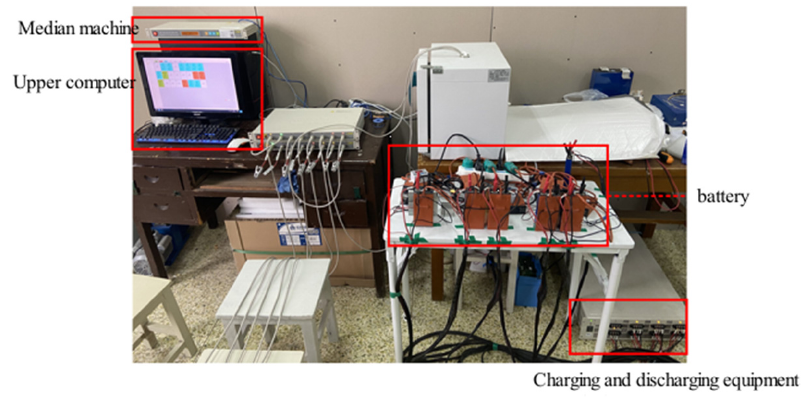
Figure 2. Battery aging test bench under thermal gradient conditions.